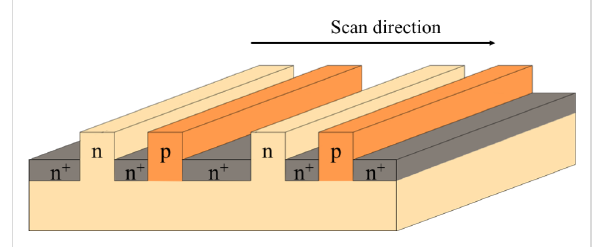
Figure 5: Schematic of the silicon substrate with three types of impu- rity pattern, that is, n-, p-, and, n + -type regions, used for the measure-